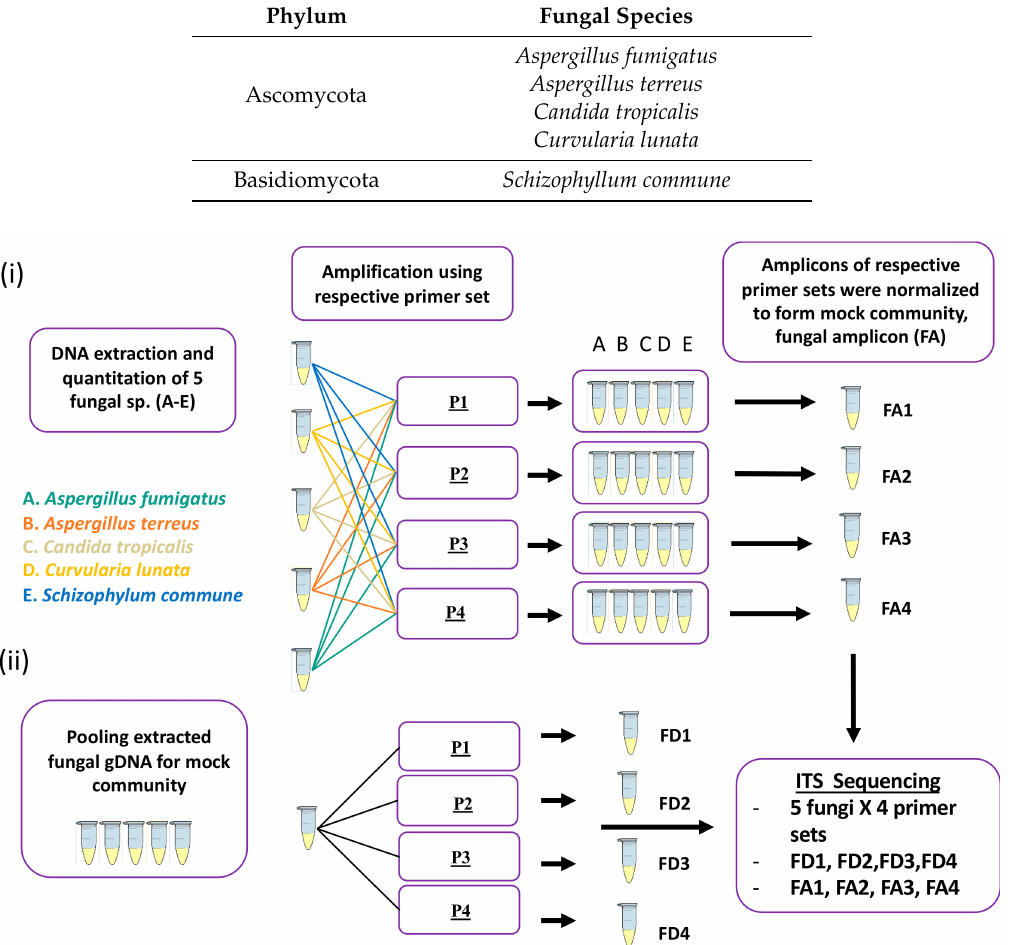
Figure 1. Schematic overview of ITS amplicon generation and mock community preparation method. The two strategies for preparation of mock communities are outlined including ( i ) fungal amplicon method; FA: ITS amplicons were generated from DNA isolated from individual strains using all the four primer sets and resultant amplicons were normalized based on copy numbers and pooled after purification and quantification. Each mock community contained five fungal species. ( ii ) Fungal DNA method; FD: DNA from fungal isolates (Table 1) was extracted, quantified, normalized, and pooled at the same concentration, and the pool was then used as a DNA template for amplification using all four primer sets (P1–P4, Table